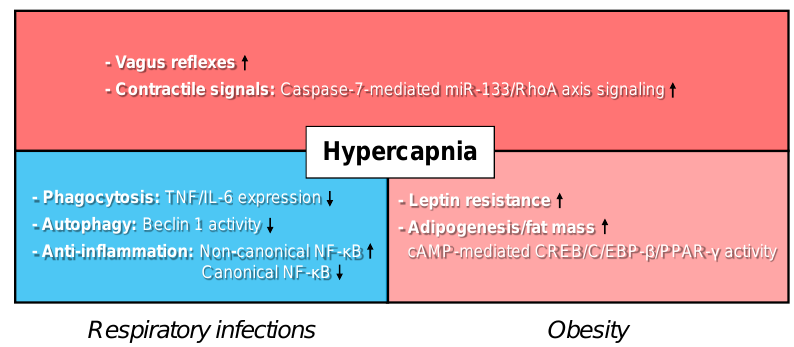
Figure 2. Schematic summarizing potential detrimental effects of hypercapnia in patients with severe asthma. Recent discoveries indicate that hypercapnia increases airway contractility, impairs the innate immune response, and promotes adipogenesis, which likely underlies the negative effects of elevated carbon dioxide (CO 2 ) on airway contraction, respiratory infections and obesity in patients with asthma.